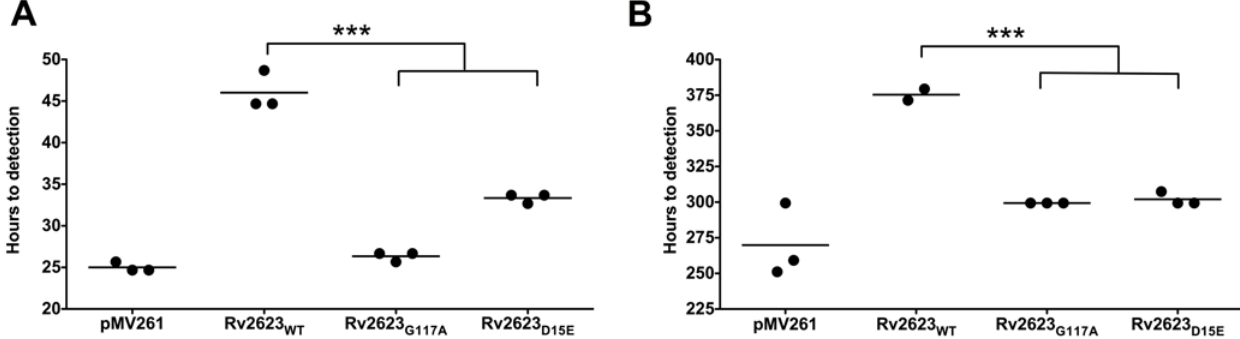
Figure 8. ATP binding by Rv2623 is required for its ability to attenuate growth. Growth of M. smegmatis (A) or M. tuberculosis (B) overexpressing wild type or mutant Rv2623 inoculated at 10 4 , 10 5 CFU/ml into a BD BACTEC 9000MB system; the time to detection of triplicate cultures is indicated. While overexpression of wildtype Rv2623 attenuates mycobacterial growth, overexpression of either ATP-binding-deficient Rv2623 mutant (Rv2623 G117A or Rv2623 D15E ) significantly shifts the time to detection back towards that of the pMV261 vector control strain. ***p , 0.001.